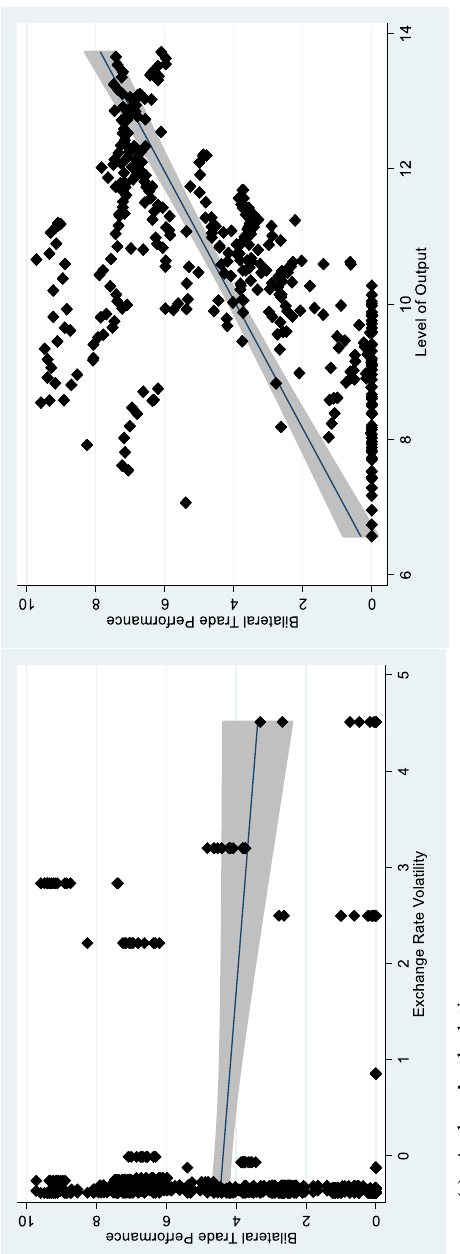
Figure 1. The stylized